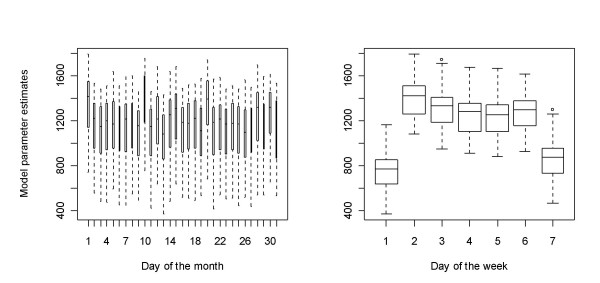
Box plots of the fitted model outputs for the generalised linear model for "on-farm" cattle deaths reported to BCMS over the period 1st Jan 2002 and 28th Feb 2005. (a) effect of day of the month (b) effect of day of the week (1- Sunday : 7-Saturday). Boxes incorporate the standard errors around the parameter estimate with error bars indicating the 95% confidence interval.